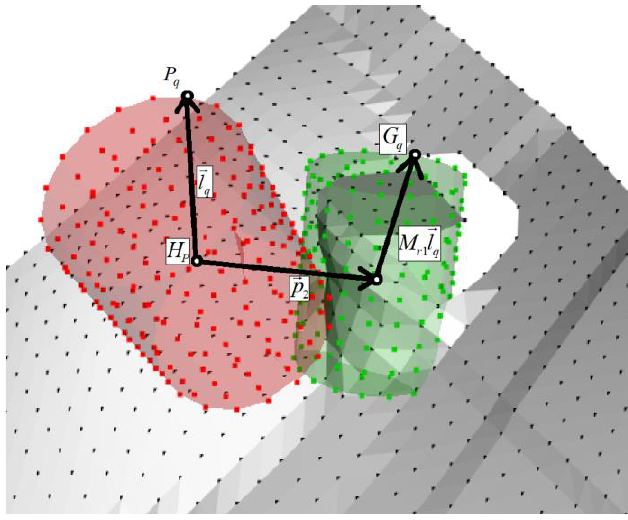
Figure 2. Preliminary alignment of point clouds.